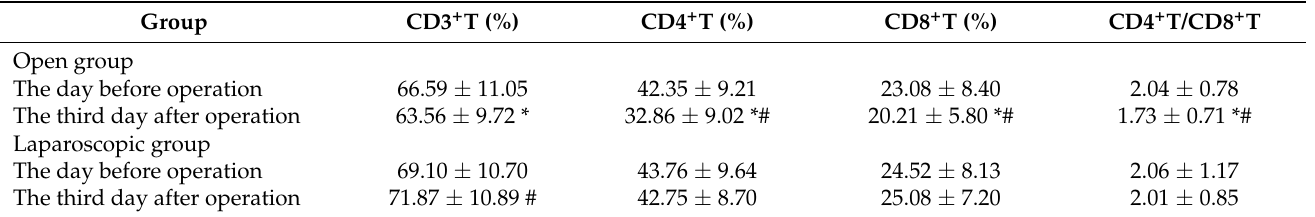
Table 2. Changes in number of immune cells in open and laparoscopic groups at different time point in pre- and post-surgery (x ±